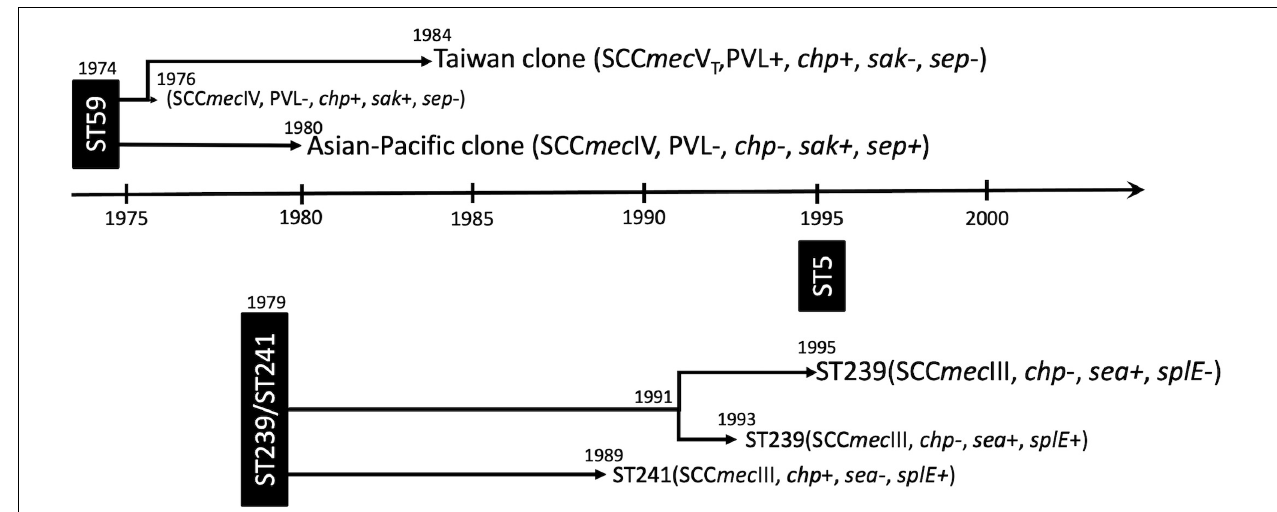
FIGURE 7 | Summary of the evolution timeline and characteristics of isolates of three prevalent methicillin-resistant Staphylococcus aureus lineages in